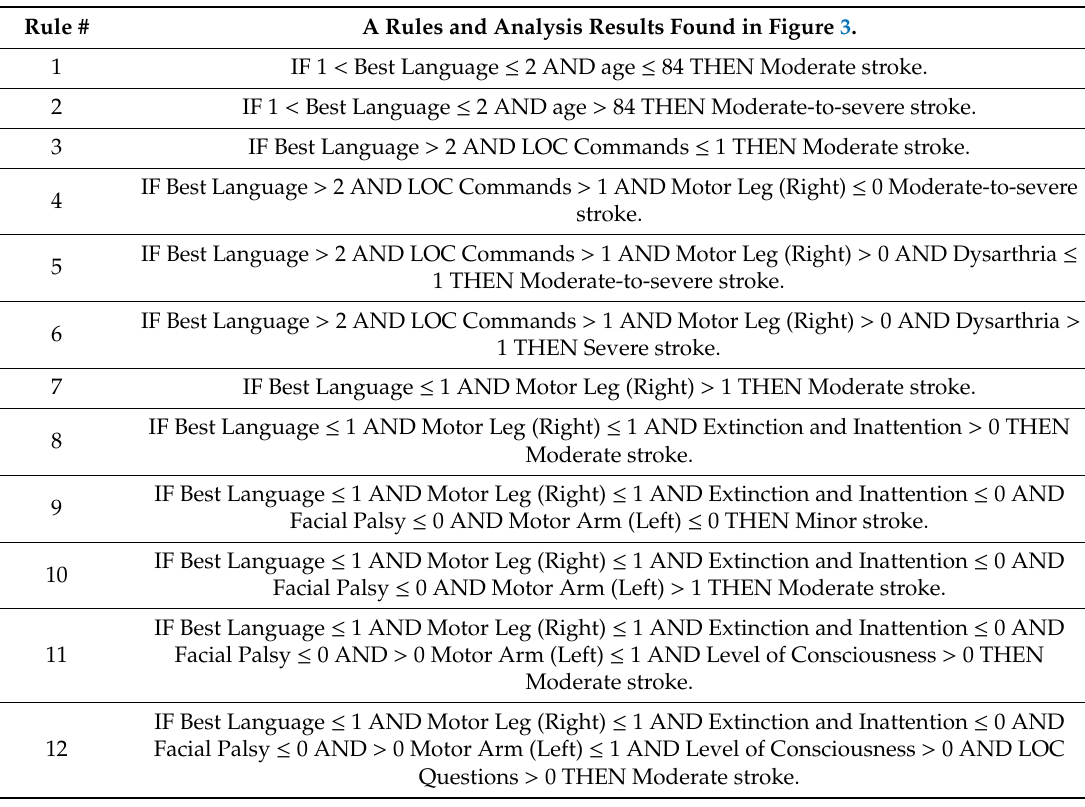
Figure 3. The C4.5-based tree structure for stroke severity types classification and prediction. Table 11. The rules for stroke severity classification and in-depth analysis.